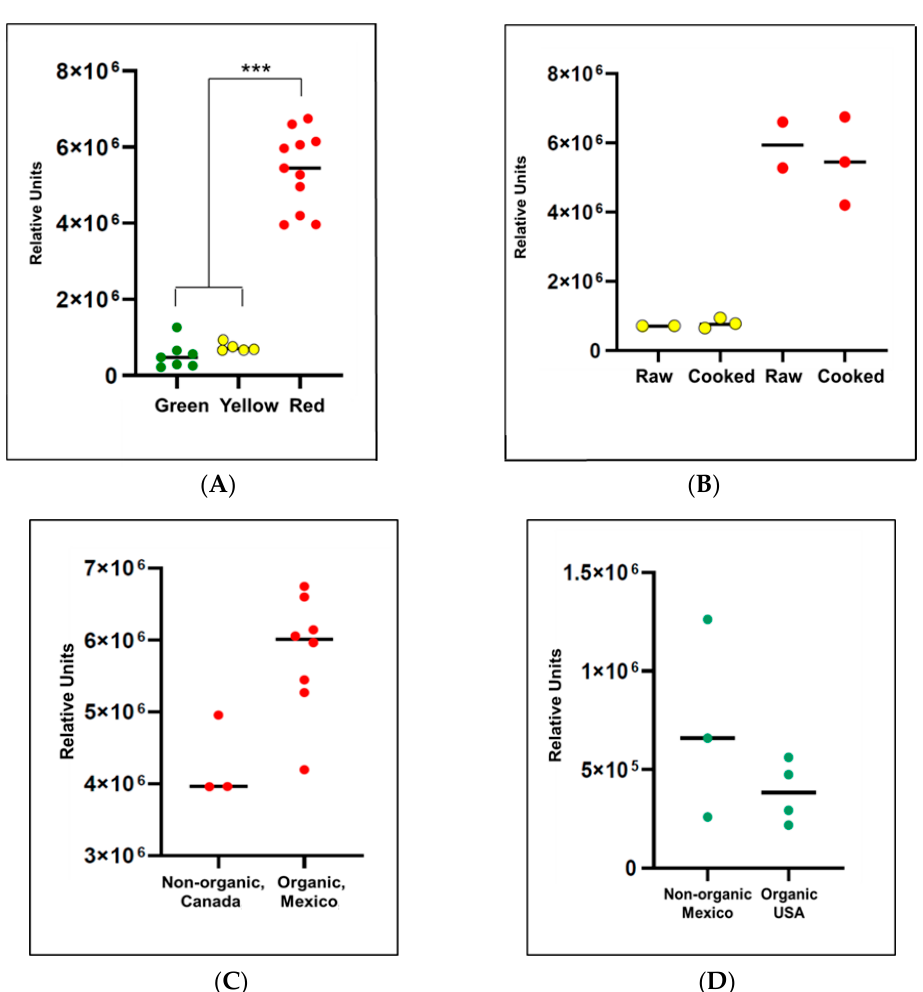
Figure 2. Relative abundance of β -cryptoxanthin detected in bell pepper samples by color. Following analysis of pepper samples using untargeted LC/MS, β -cryptoxanthin levels were compared according to their relative abundance across samples. ( A ) Red bell pepper has significantly higher levels compared to green and yellow. *** p < 0.001; ( B ) To determine whether cooking had any impact, each pepper was divided, three samples were heated for 5 min, and two samples remained raw. There was no statistically significant difference between the cooked peppers compared to raw overall or within either pepper color; ( C ) There was a nominal statistical difference between one non-organic, Canadian red pepper compared to two organic, Mexican red peppers; ( D ) There was no statistical difference between the non-organic, Mexico grown green pepper vs. the organic US grown green pepper.